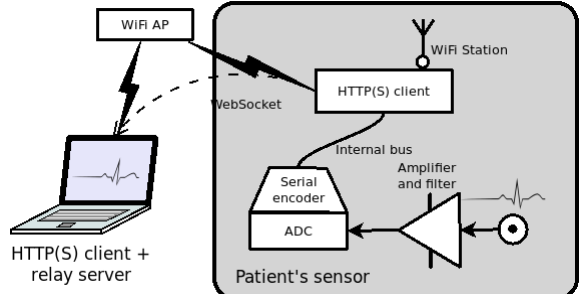
Figure 10. Test setup to measure the processing pipeline in isolation, independent from Wide Area Network (WAN)